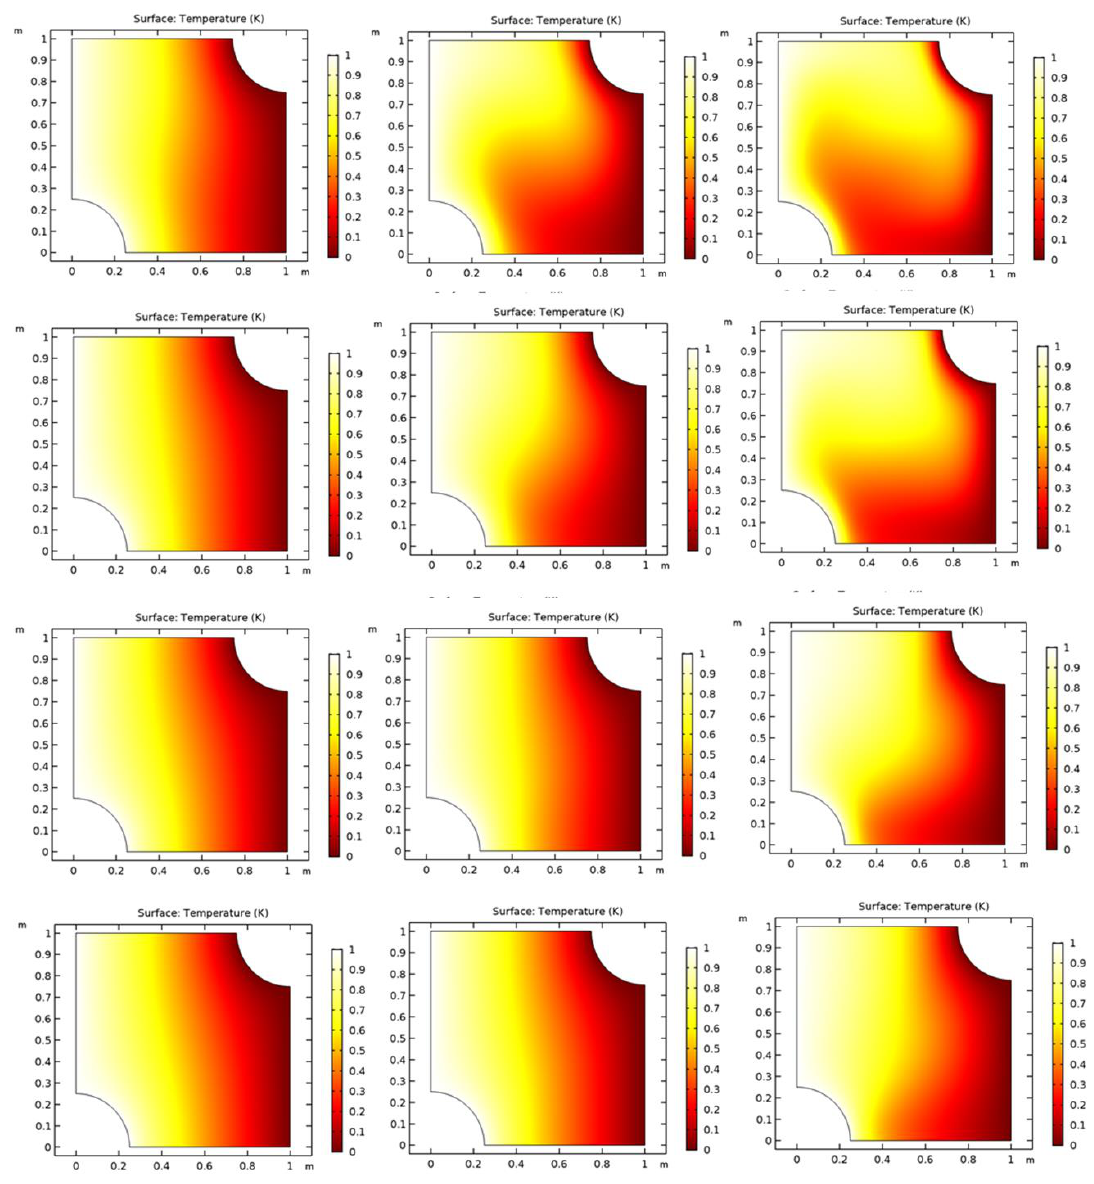
Figure 4. Effect of Hartmann number and Rayleigh number on the surface temperature distribution. Figure 4. E ff ect of Hartmann number and Rayleigh number on the surface temperature